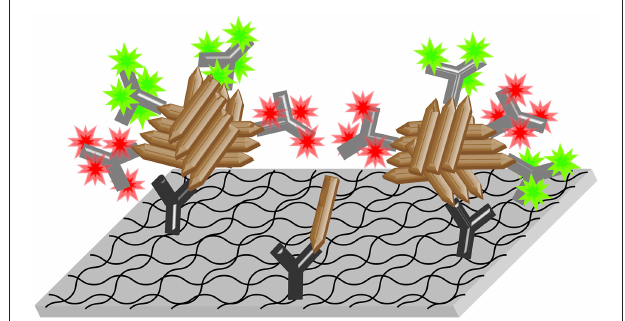
FIGURE 1 | Scheme of the sFIDA assay. A β -specific capture antibodies (dark gray Y symbols) are immobilized on a functionalized glass surface. A β oligomers (brown rods) present in the sample bind to the capture antibodies and are detected by fluorescence labeled (colored stars) anti-A β -antibodies (light gray Y symbols). The surface is then imaged by dual-color microscopy. In this version of the assay, all three of the applied antibodies (one capture and two different detection antibodies labeled with two different fluorochromes) bind to overlapping epitopes at the N-terminus of A β , which corresponds to the spiky ends of the brown rods in the scheme above. Thereby, only oligomers with multiple epitopes, but not monomers, are able to bind detection antibodies while bound to the capture and thus yield detectable